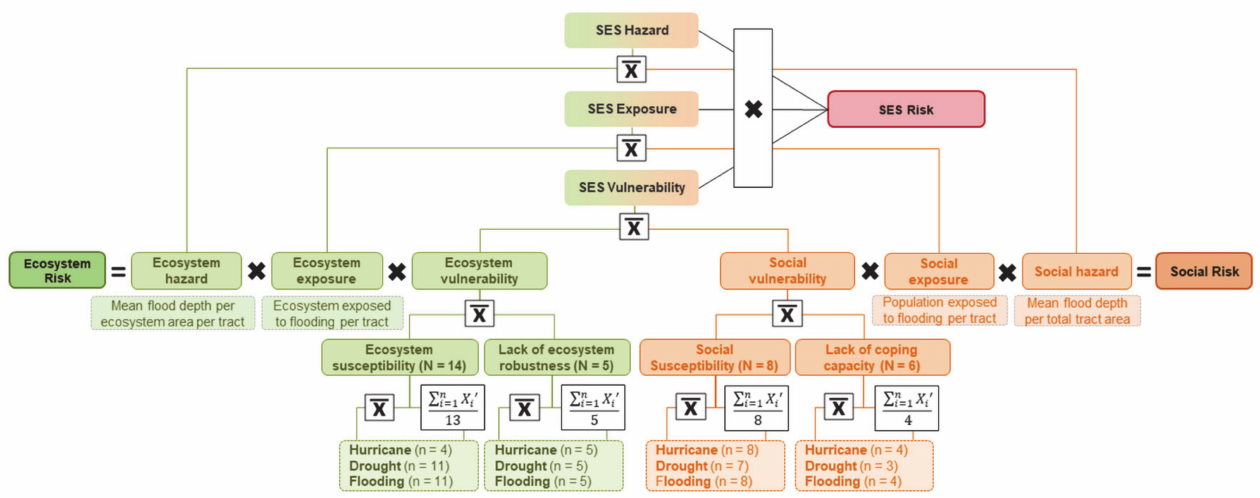
Figure 2. Aggregative modular structure of Global Delta Risk Index (GDRI) with aggregation occurring from the bottom up for each risk component—hazard, exposure, and vulnerability—generating intermediary scores for each subcomponent. Multi-hazard scores always use arithmetic means (X) of all indicators within any given subcomponent. Hazard-specific scores use means except for the calculation of the first four vulnerability subcomponents, for which the varying counts of hazard-relevant standardized indicator values are summed and divided by the total number of indicators in that subcomponent. Social risk and ecosystem risk are calculated as the products of social (or ecosystem) hazard, exposure and vulnerability. Adapted from (Hagenlocher et al., 2018)